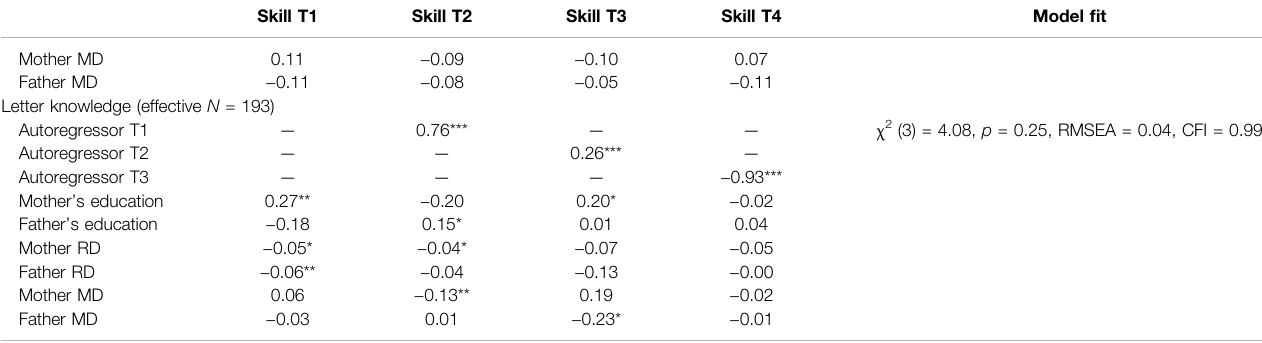
TABLE 3 | ( Continued ) The standardized model estimates for parental measures predicting children ’ s skills.